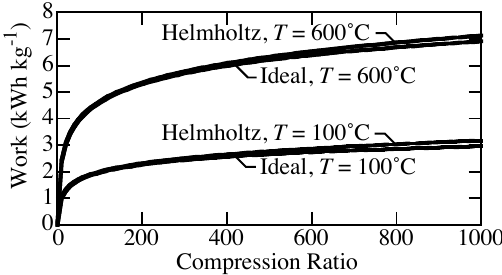
Figure 3. Comparison of compression work for real-gas and ideal-gas equations of state from 1 to 1000 bar at temperatures of 100 ◦ C and 600 ◦ C.